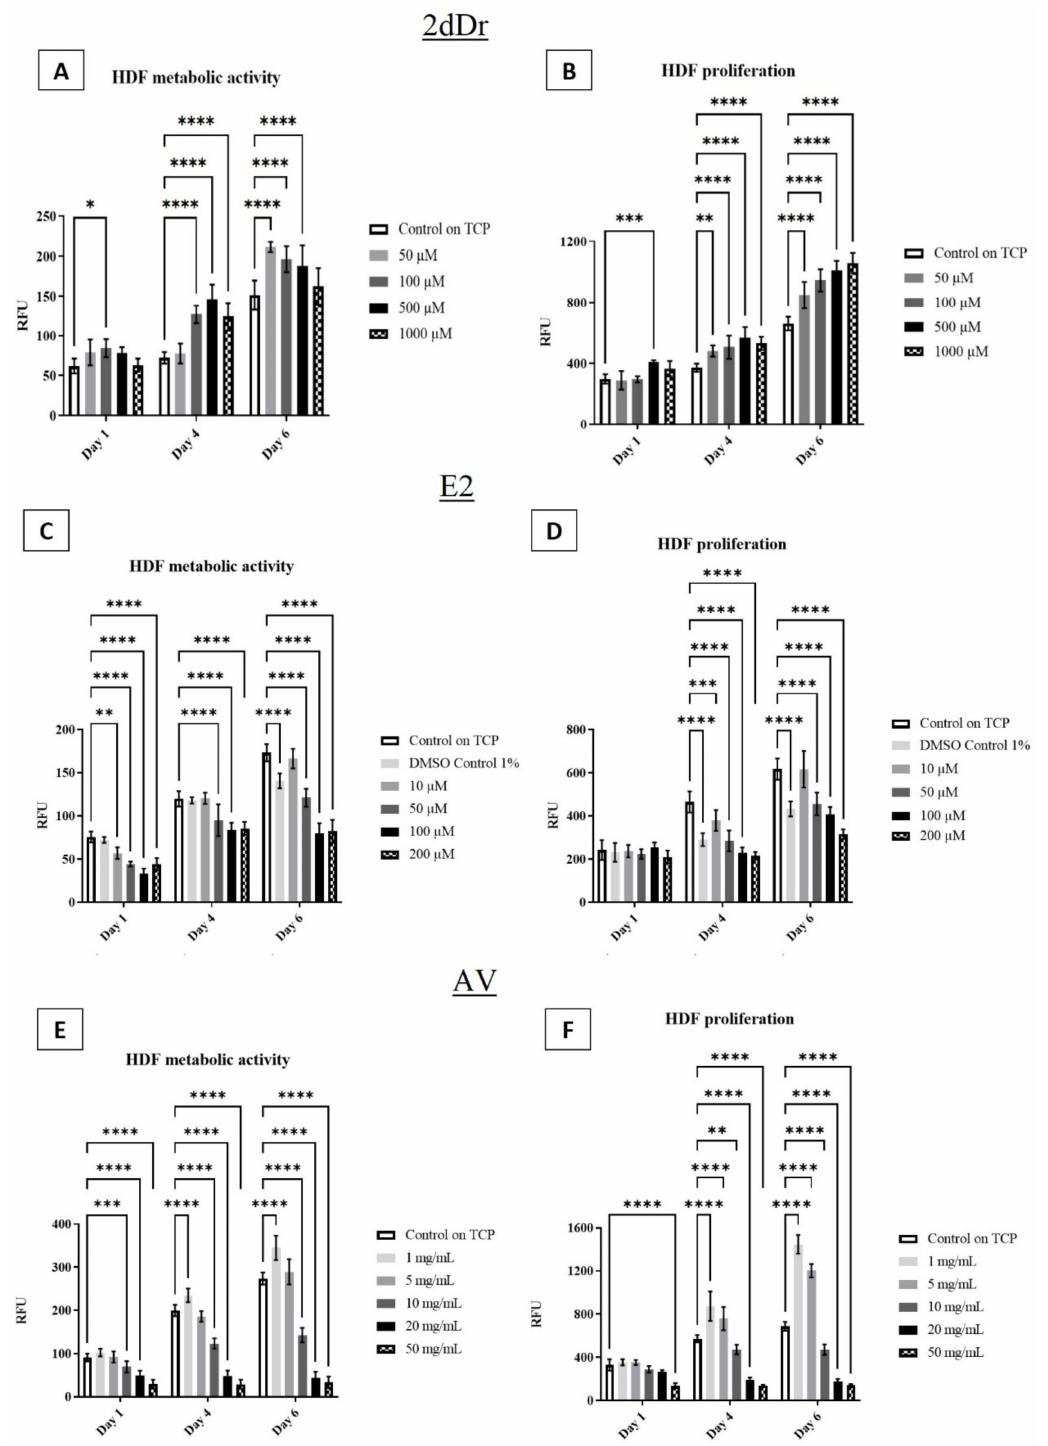
Figure 4. HDF metabolic activity and proliferation in the presence of solubilized 2dDr ( A , B ), E2 ( C , D ), and AV ( E , F ) at different concentrations. * p < 0.05, ** p < 0.01, *** p < 0.001, **** p < 0.0001. N = 3, n =